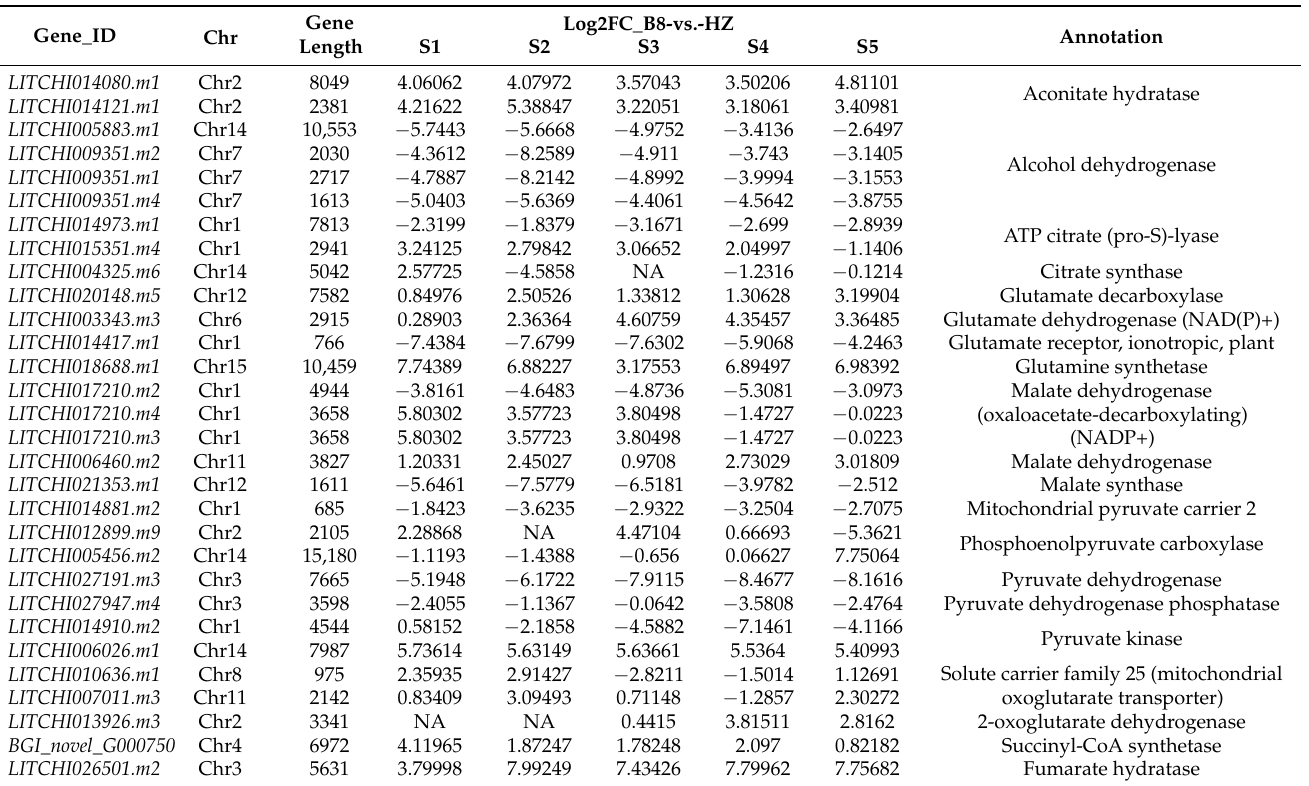
Table 1. List of potential candidate genes associated with variation in litchi fruits’